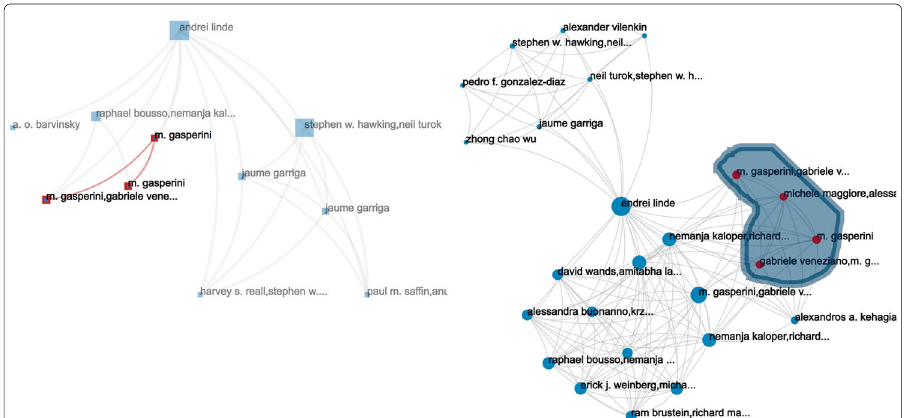
Fig.16 Detangler(Renoustetal.2015)viewofthesubgraphinducedbyID9503097(aggregatedflow).Onthe left the citation network (size is the aggregated flow), on the right the layer network (size is the entanglement